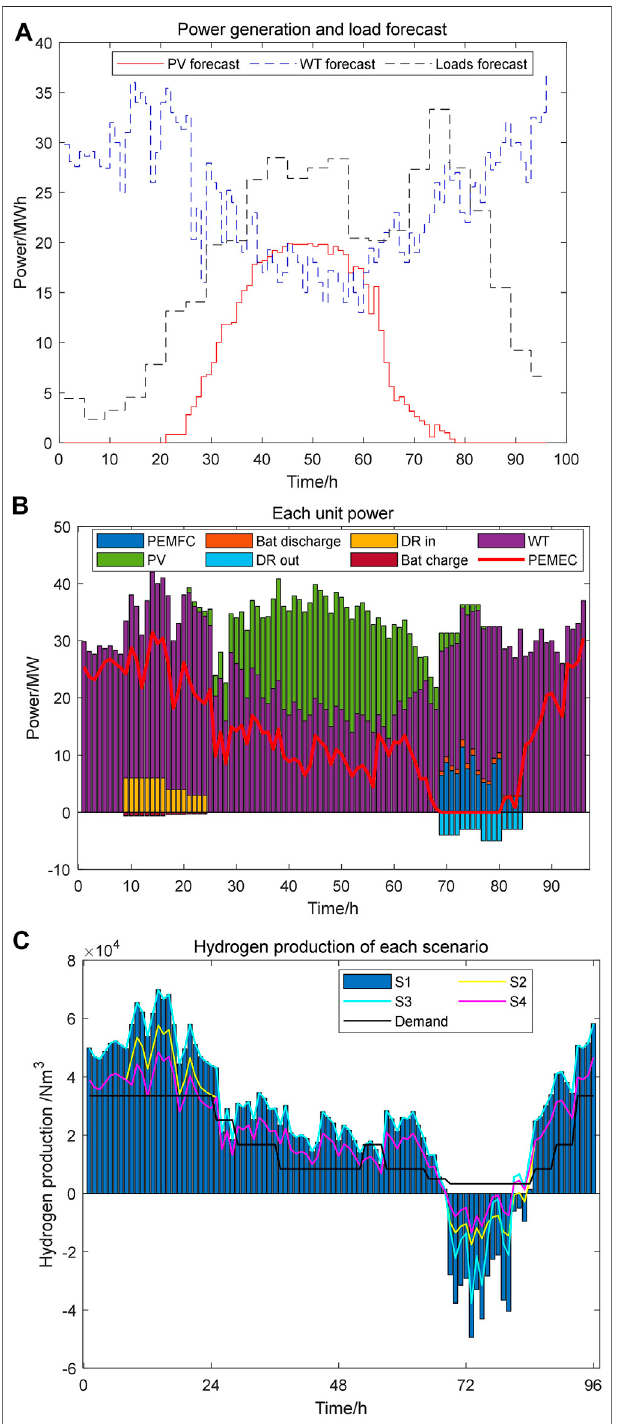
FIGURE 11 | (A) Intra-day forecast results of a typical winter day, (B) each unit power of a typical winter day, (C) hydrogen production and hydrogen demand of a typical winter